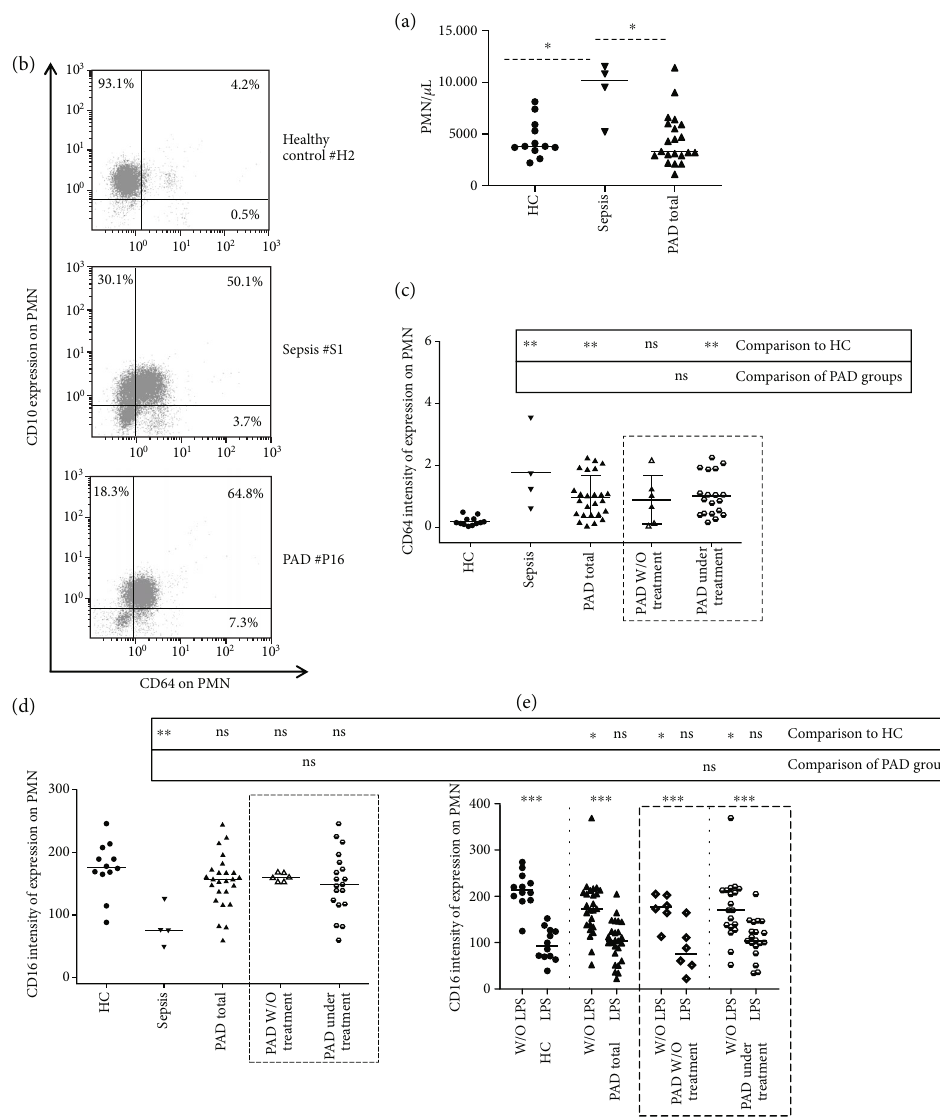
Figure 1: (a) PMN absolute numbers (per μ L) of whole peripheral blood of the patients and controls of the study. (b) Representative dot plots of CD64 expression on PMN. (c) CD64 intensity of expression on polymorphonuclear cells (PMN) of the patients and controls of the study. (d) CD16 intensity of expression on whole-blood PMN of the patients and controls of the study at basal state. (e) After incubation of whole blood without and with LPS. The lines represent the median values. Statistical analyses were performed by the Mann – Whitney U test. The Wilcoxon-matched paired analysis was performed to compare same subjects under culture conditions; ∗ p < 0 : 05 ; ∗∗ p < 0 : 01 ; ns, not signi fi